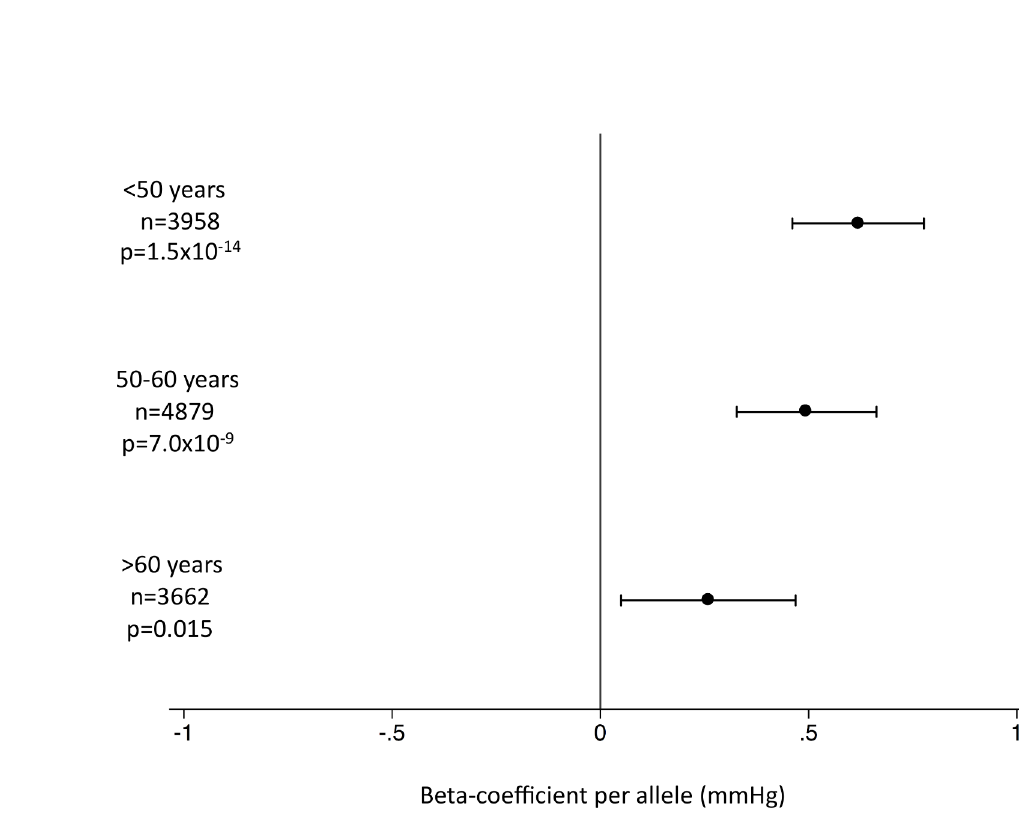
PLOS Medicine | DOI:10.1371/journal.pmed.1001841 June 16,